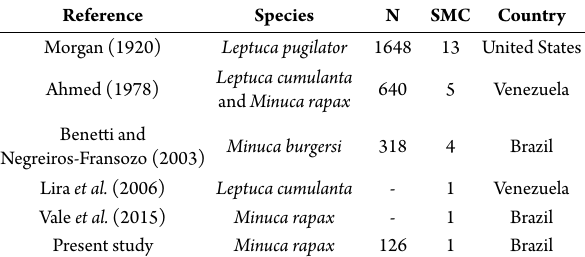
Table 1 . Bilateral hypertrophy in fiddler crab species (according to current generic combinations) captured in natural environments. N, number of individuals; (-), not reported; SMC, super-male chelipeds (according to Morgan, 1920).